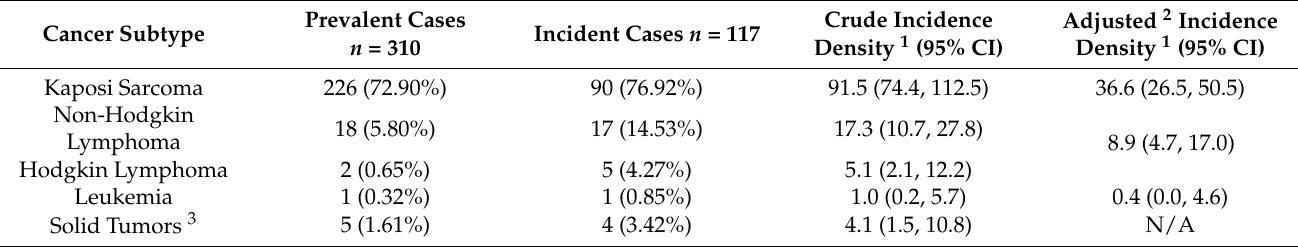
Table 2. Distribution of subtypes of cancer among children with HIV infection in the Baylor College of Medicine International Pediatric AIDS Initiative (BIPAI) cohort.